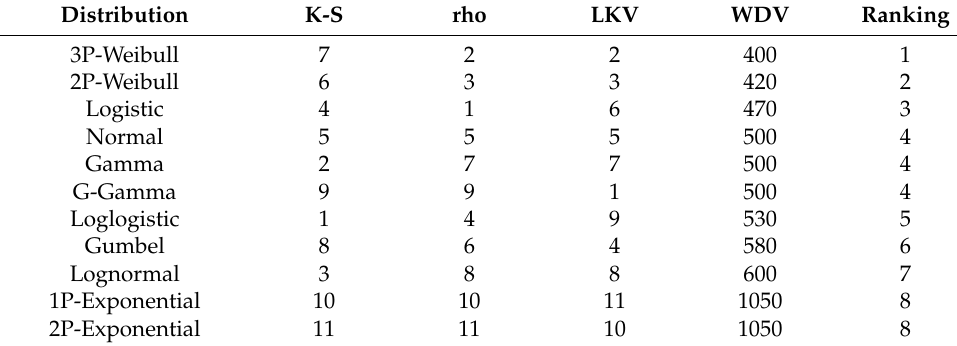
Table 5. Ranks of distributions for estate body